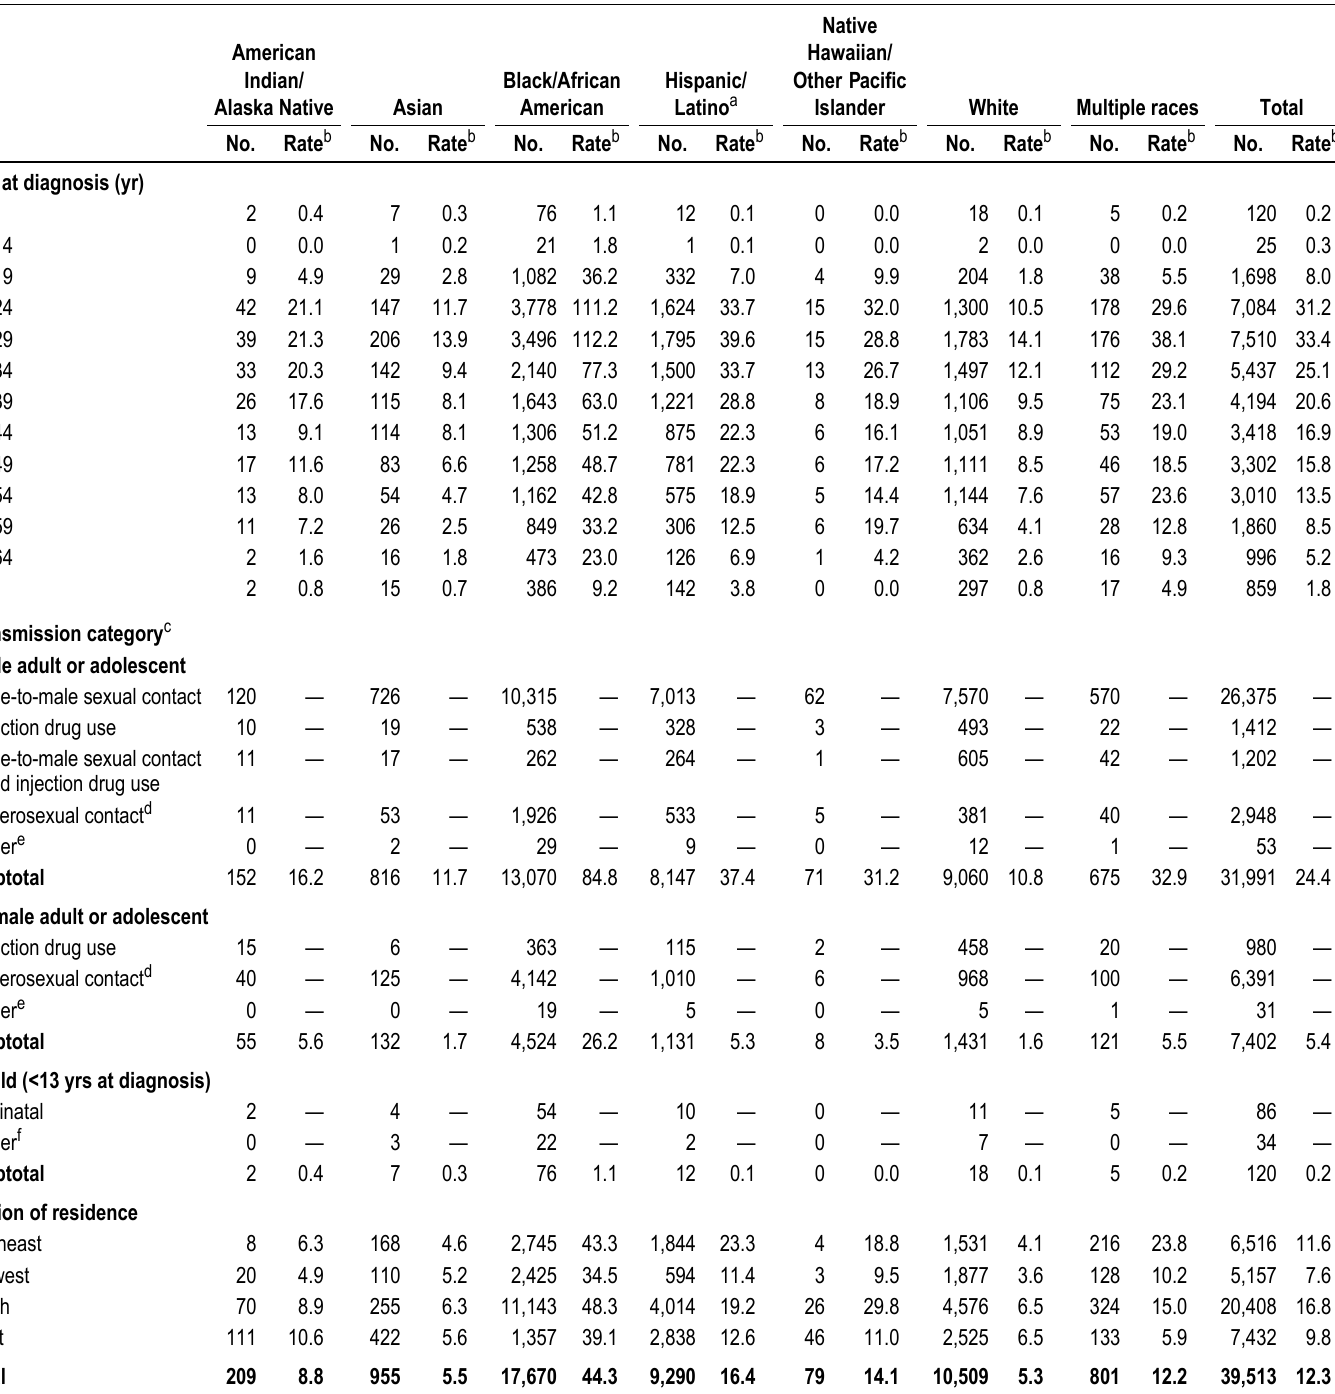
Table 3a. Diagnoses of HIV infection, by race/ethnicity and selected characteristics, 2015—United